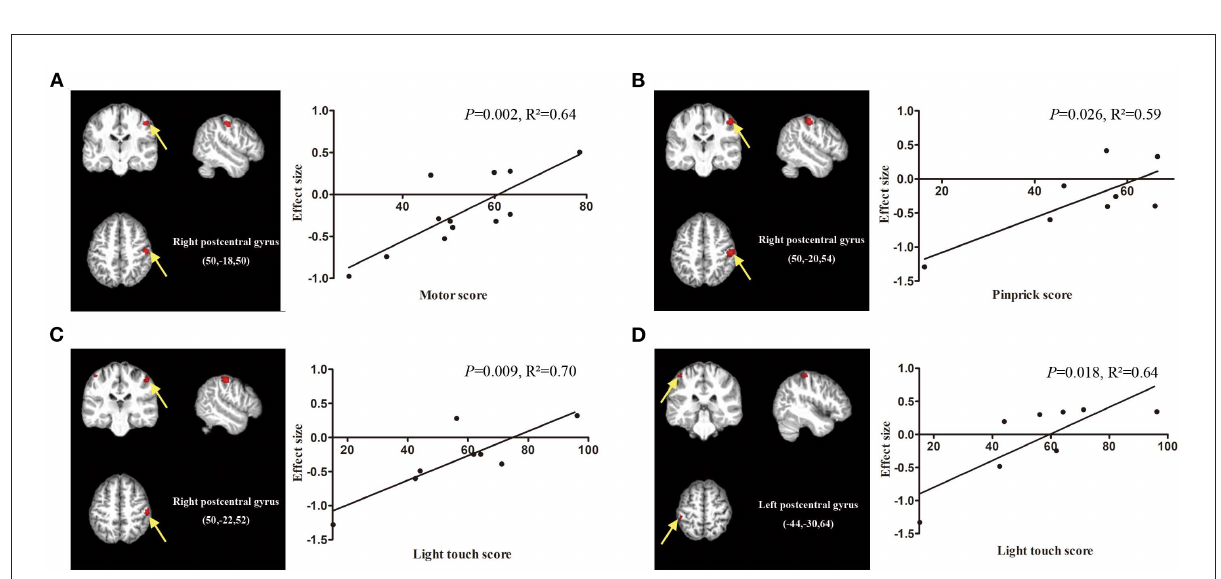
FIGURE5 Meta-regression analysis showing the correlation between clinical score and gray matter volume in patients with spinal cord injury (SCI). (A) The American Spinal Injury Association (ASIA) motor scores of SCI patients are positively correlated with gray matter volumes in the right postcentral gyrus ( P = 0.002, R ² = 0.64). (B) The ASIA pinprick scores of SCI patients are positively related to gray matter volumes in the right postcentral gyrus ( P = 0.026, R ² = 0.59). (C) The ASIA light touch scores of SCI patients are positively related to gray matter volumes in the right postcentral gyrus ( P = 0.009, R ² = 0.70) and (D) left postcentral gyrus ( P = 0.018, R ² = 0.64). The effect sizes in the graph were extracted from the peak of maximum slope significance. Each study is represented as a dot.